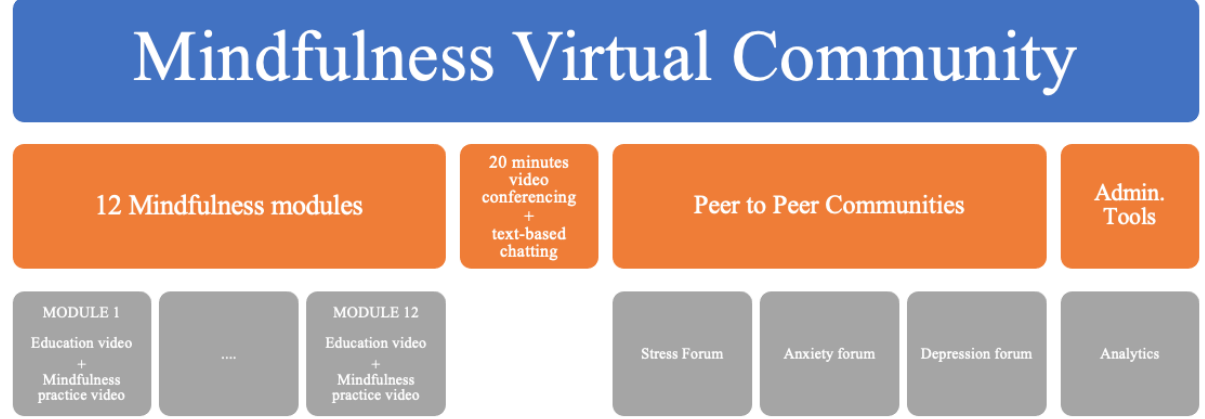
Figure 1. The Mindfulness Virtual Community